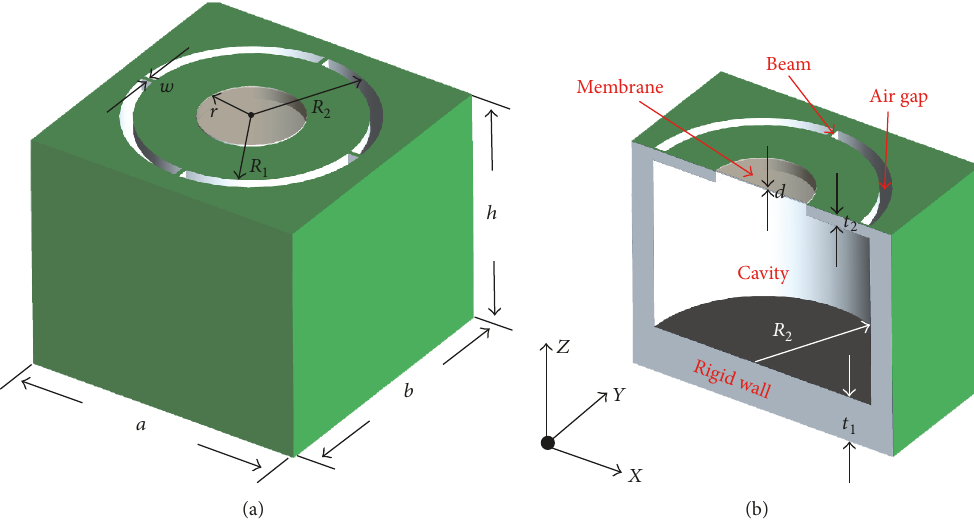
Figure 1: (a) Schematic map of acoustic metasurface unit cell and (b) longitudinal section of the unit cell. The unit cell is composed of a cavity with acoustically hard walls, which is capped with a rigid circular ring. The inside of the ring is a clamped membrane, and the outside is an air